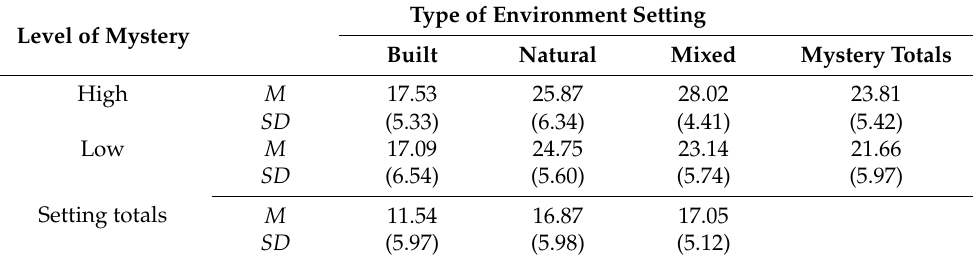
Table 3. Post-Transformation Descriptive Statistics for the Effects of Mystery and Environment Settings on the PRS.